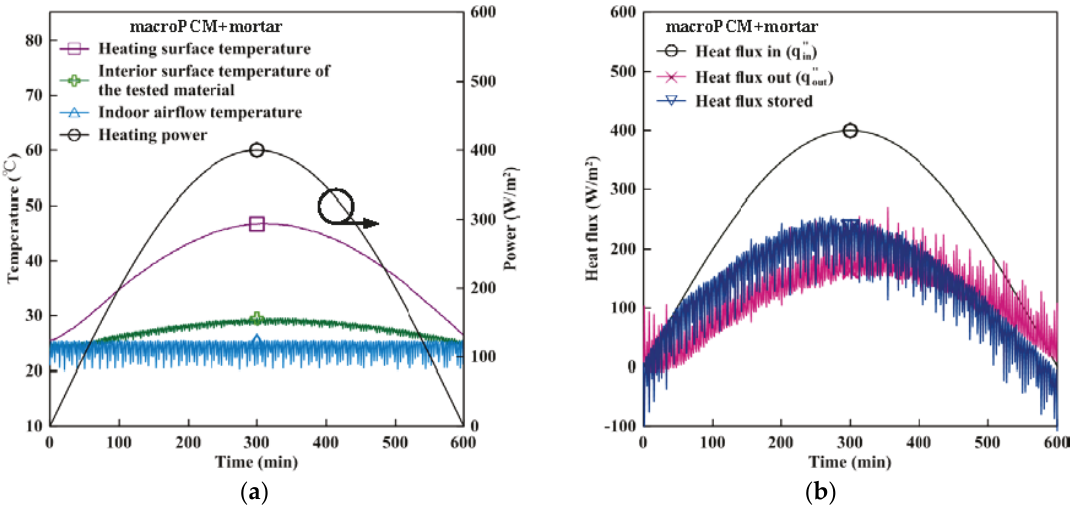
Figure 6. Heat transfer behavior of macroPCM + mortar ( G s,o = 400 W/m 2 ): ( a ) Temperature changes with time; ( b ) Heat flux changes with time.